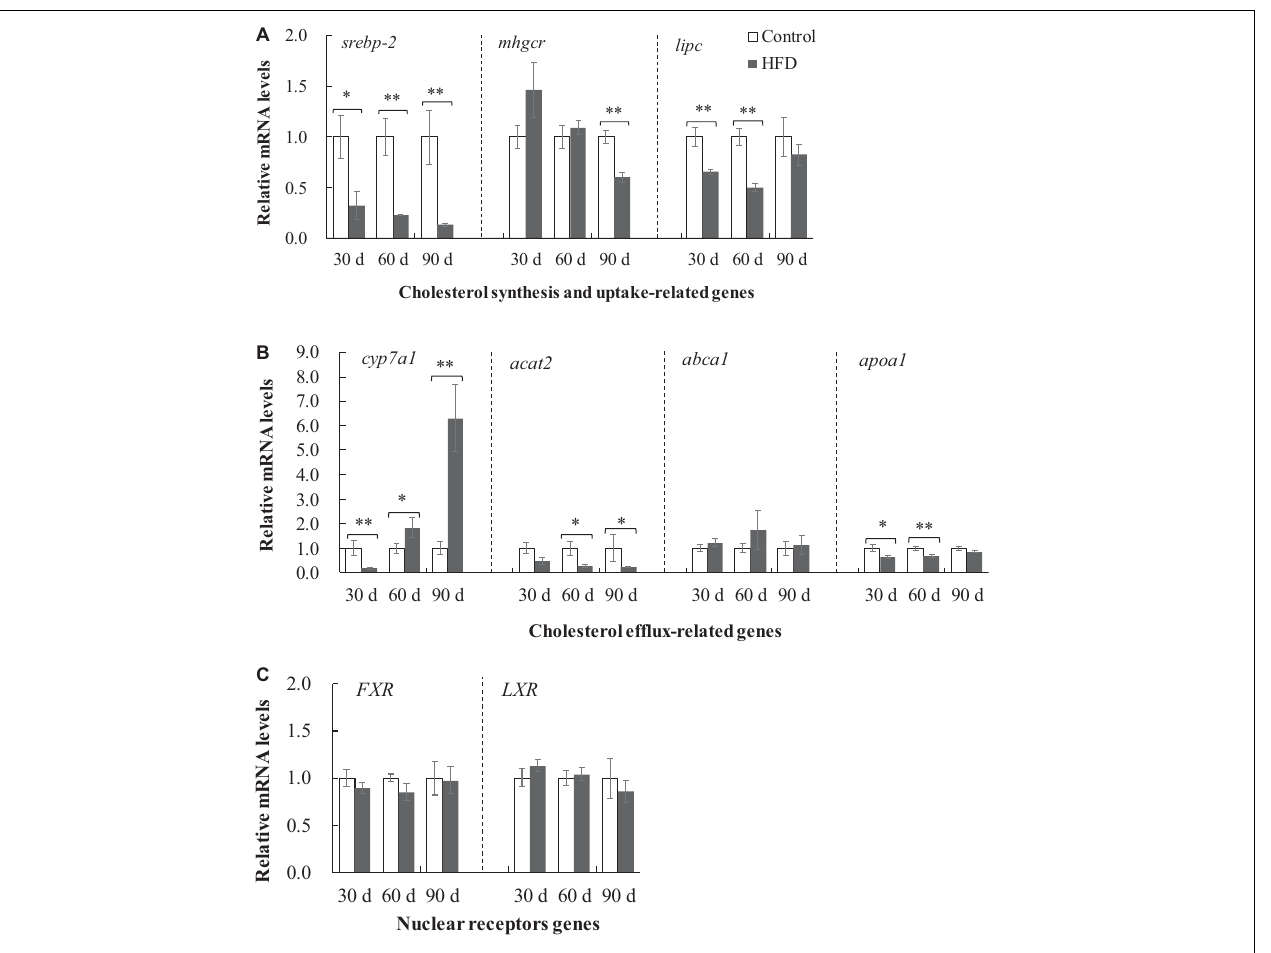
FIGURE 5 | Expression of cholesterol metabolism-related genes in liver of tilapia fed on control diet and HFD for 90 days. (A) Expression of cholesterol synthesis and uptake-related genes including srebp-2 , mhgcr and lipc ; (B) expression of cholesterol efflux-related genes including cyp7a1, acat2, abca1 and apoa1 ; (C) expression of nuclear receptors genes including FXR and LXR . The values are normalized to control values and expressed as means ± SEM ( n = 10); ∗ P < 0.05 and ∗∗ P < 0.01 versus control at same